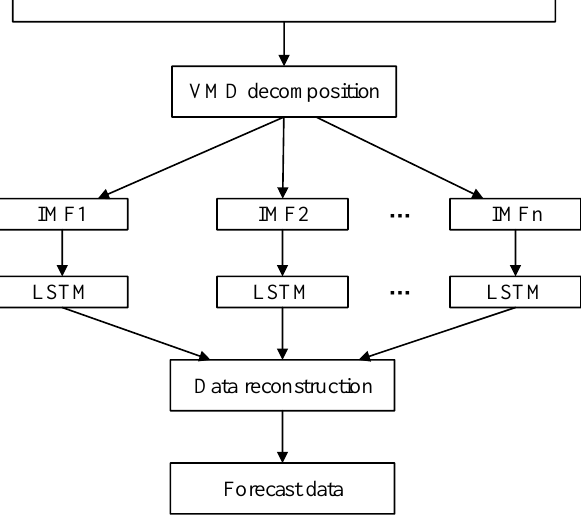
Figure 15. CO concentration prediction process based on VMD-LSTM.